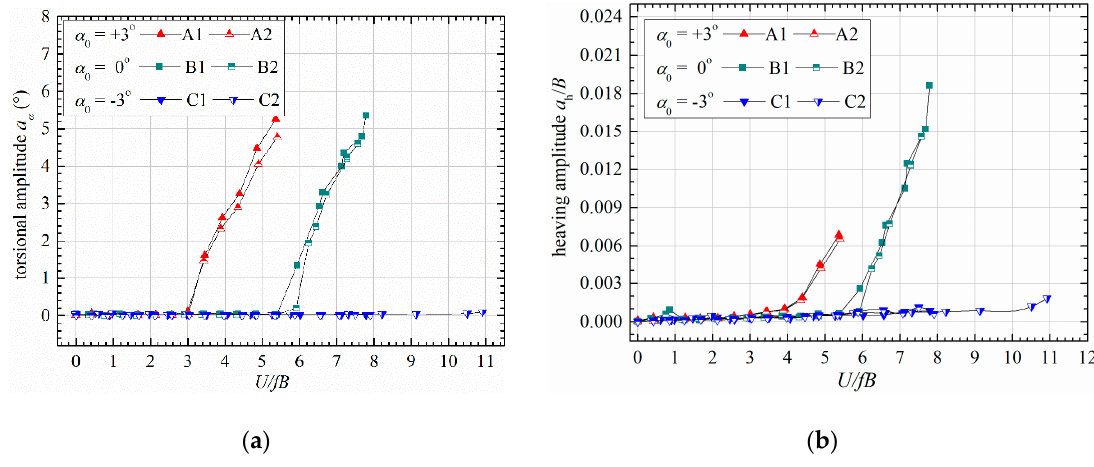
Figure 7. Evolution of stable amplitudes with reduced wind speed under different attack angles. ( a ) Torsional amplitude; ( b ) heaving amplitude.